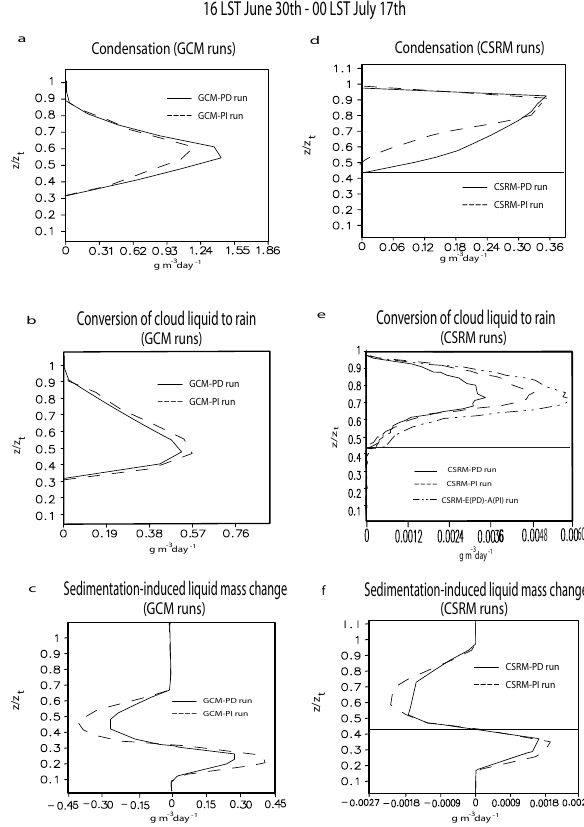
Fig. 9. Vertical distribution of time- and area-averaged (a) and (d) condensation for the GCM runs and the CSRM runs, respectively, (b) and (e) conversion of cloud liquid to rain for the GCM runs and the CSRM runs, respectively, and (c) and (f) sedimentation- induced liquid mass change for the GCM runs and the CSRM runs, respectively, in gm − 3 day − 1 over the period before 00:00 LST on 17 July when stratocumulus clouds dominate for the CSRM and GCM runs. The solid horizontal line in (d), (e), and (f) is the average cloud-base height normalized with respect to cloud-top height ( z t )